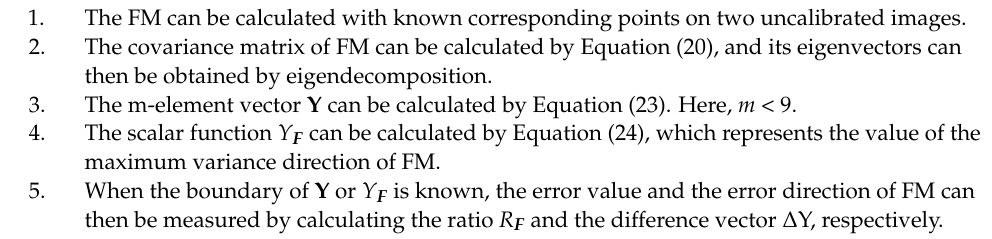
Algorithm 1. The calculated steps of FM